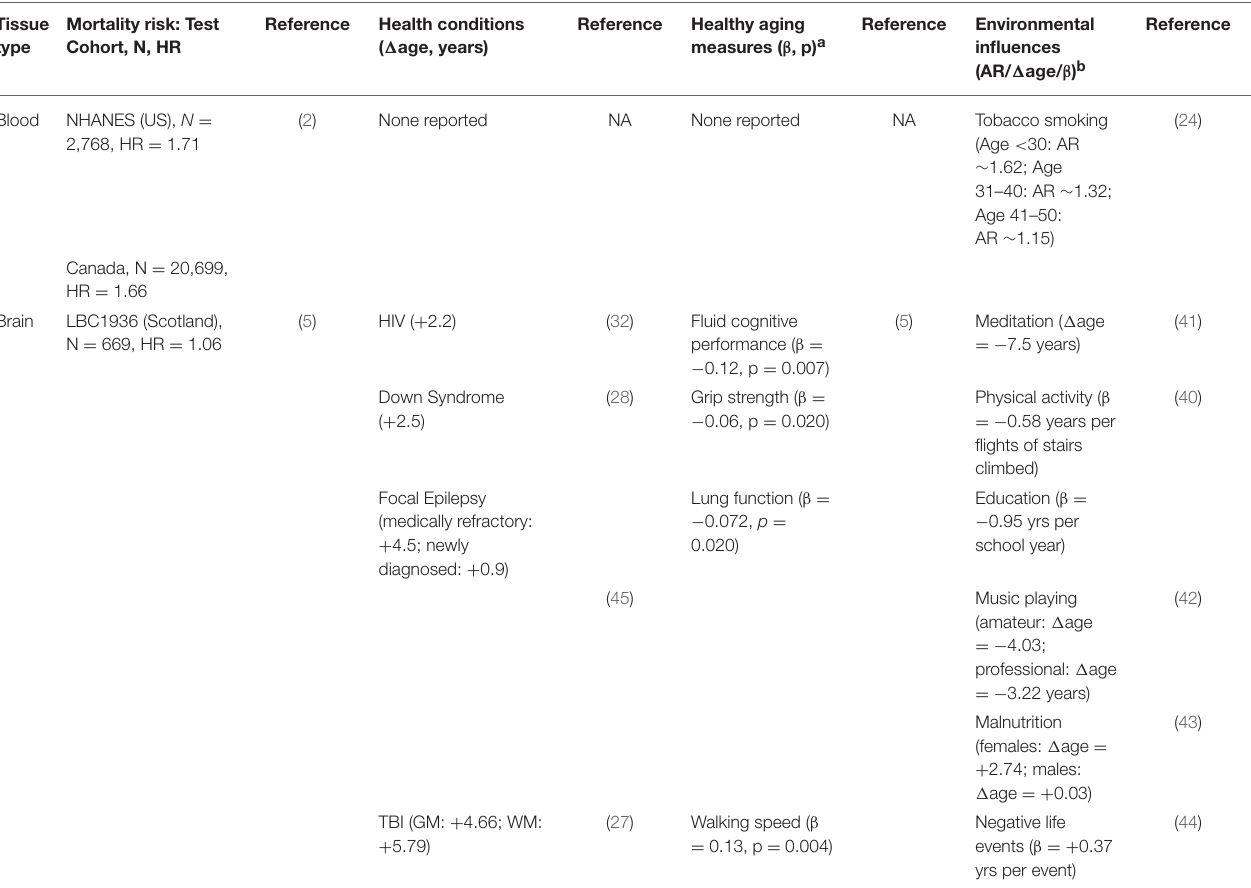
TABLE 2 | Associations of biological age estimates described here with health conditions, mortality risk, frailty measures, and environmental factors. Tissue Mortality risk: Test type Cohort, N,